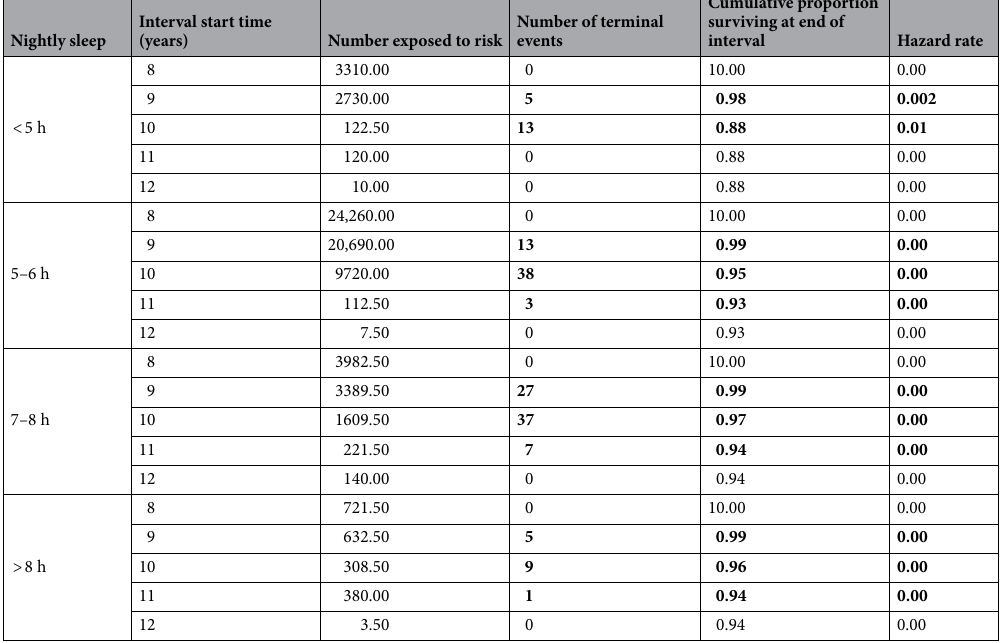
Table 3. Hazard rate, number at risk and number of event based on nightly sleep in study population. Significant values are in bold.